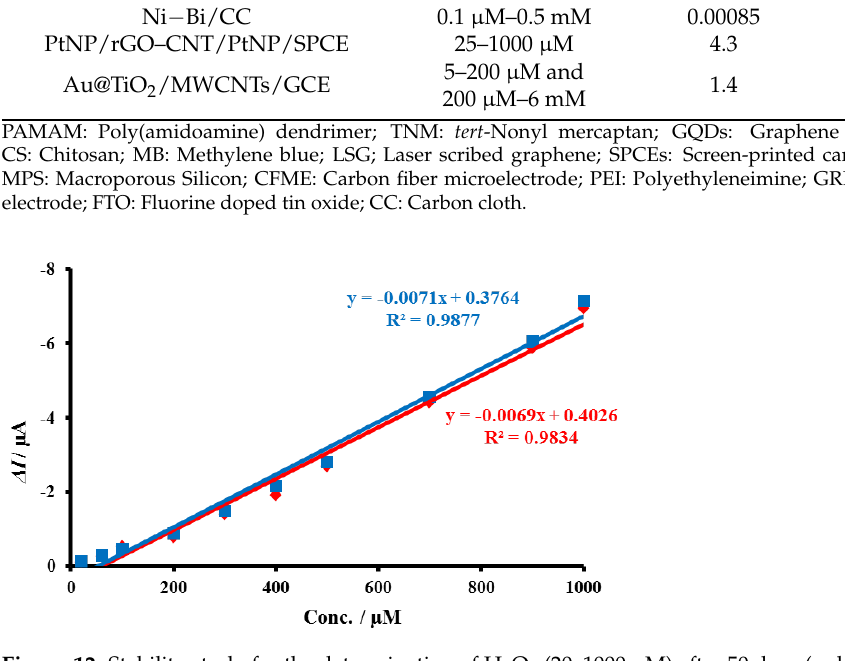
Table 3. The H 2 O 2 (200 µM) recovery data for the proposed electrode in the presence of common interferents (10-fold concentration, 2 mM).